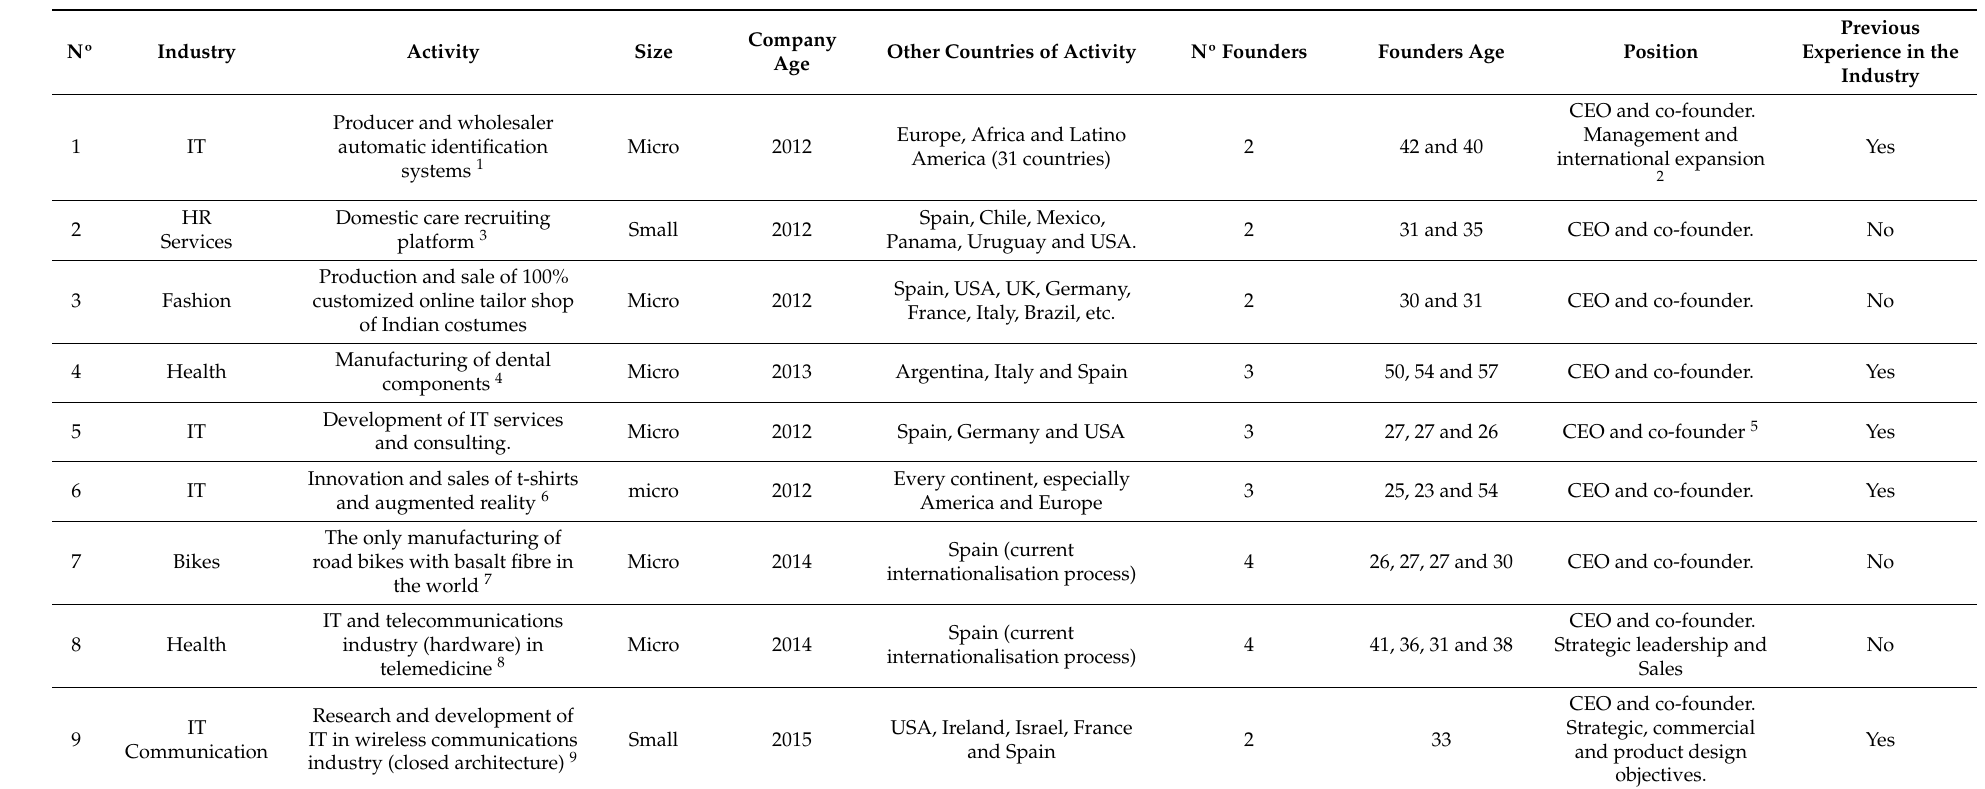
Table A1. Contextual setting of the interviewee